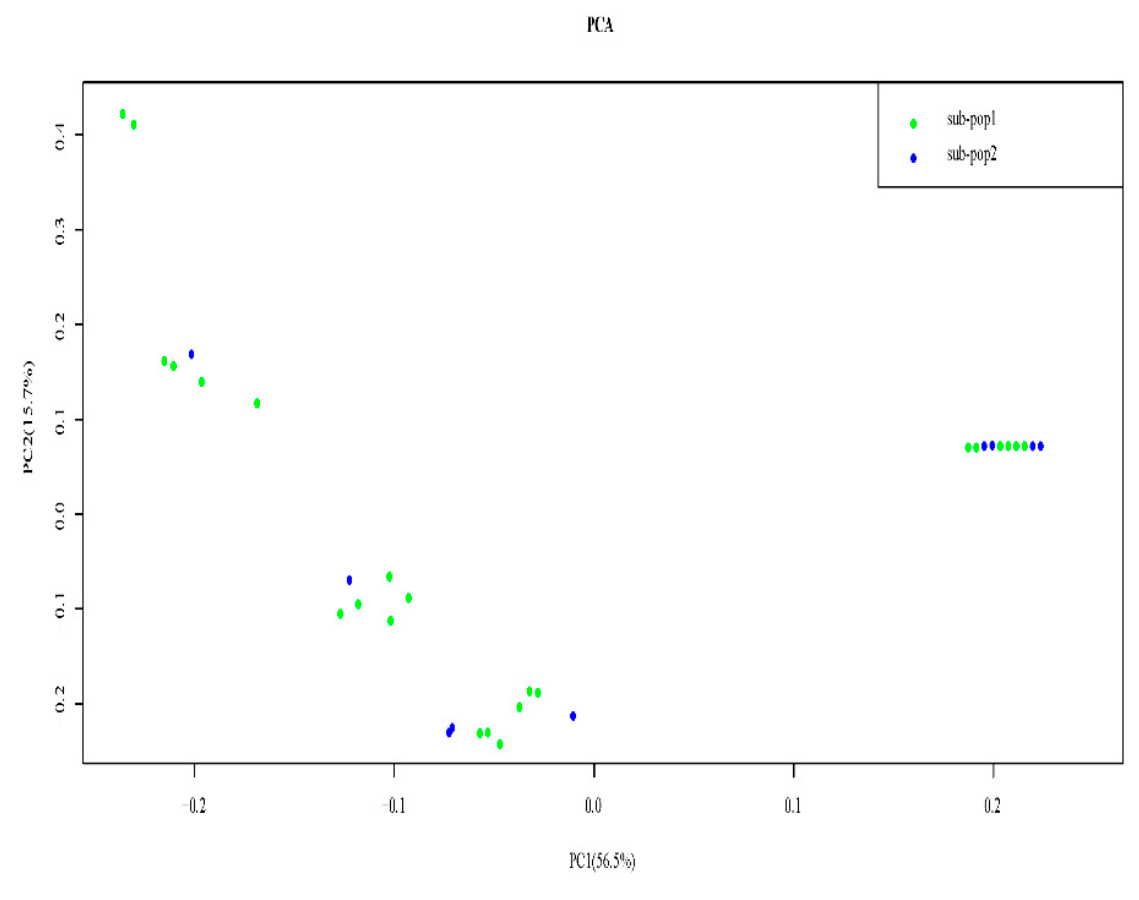
Figure 4. Principal component analysis of the 32 genotypes of durian in the durian plantations in Hainan. The genotypes with blue (round shaped) and green (triangle) colors represent Groups 1 and 2, respectively. The less the distance between the samples, the smaller the genetic background differences between the samples.